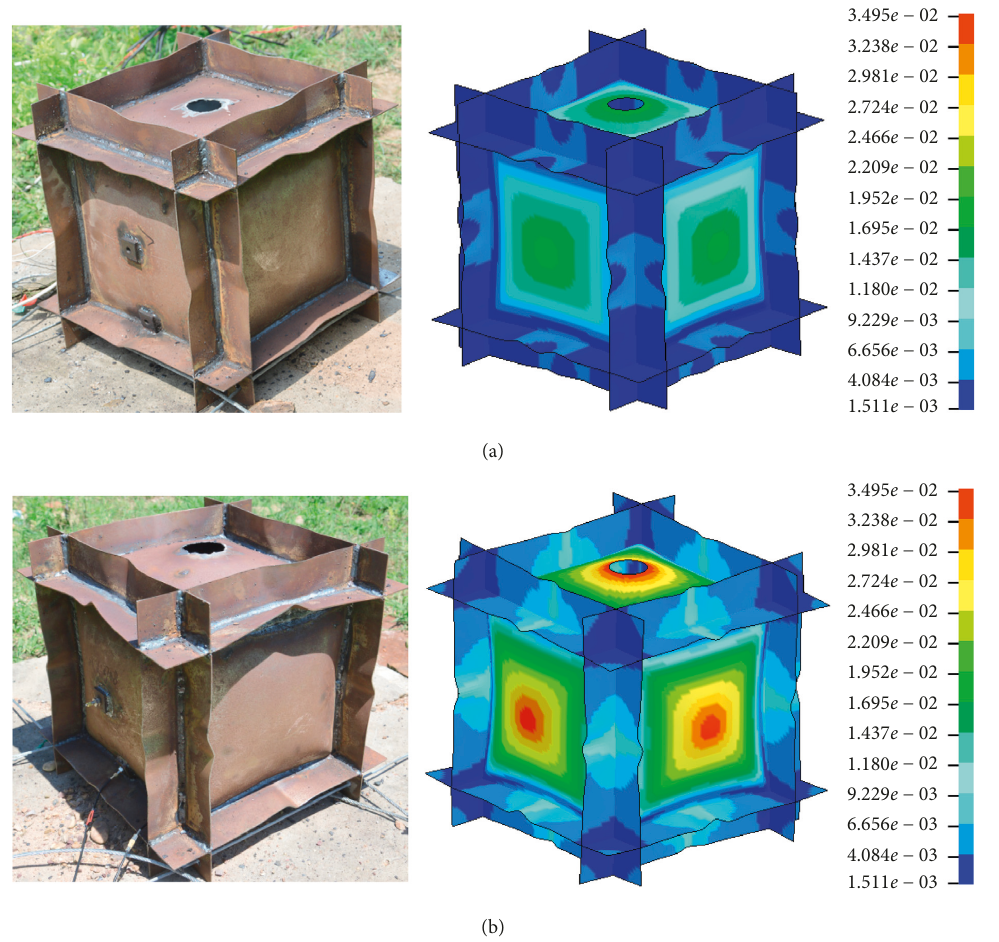
Figure 3: Deformation comparison between experimental result and numerical result (the left picture is the experimental result and the right is numerical). (a) 12.8g TNT. (b) 40.2g TNT.